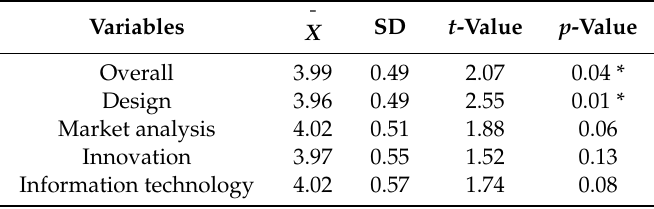
Table 1. Descriptive and inferential statistics analysis.